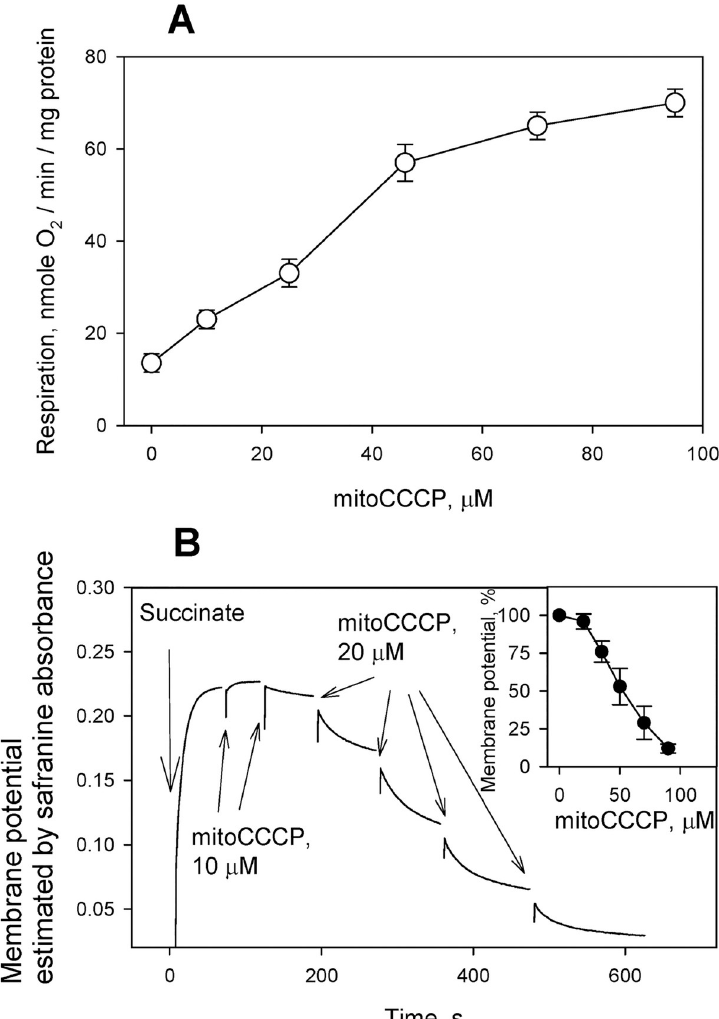
Fig 5. A . Dose dependence of respiratory stimulation by mitoCCCP with succinate as a substrate of mitochondria. Shown are Mean ± S.D. (n = 4). For experimental conditions, see Materials and methods. B . Effect of mitoCCCP on the mitochondrial membrane potential in rat liver mitochondria (RLM) estimated by measuring absorbance changes of the potential-sensitive dye safranine O (15 μ M). For experimental conditions, see Materials and methods. Insert: dose dependence of the effect of mitoCCCP on the membrane potential of RLM (Mean ± S.D., n =